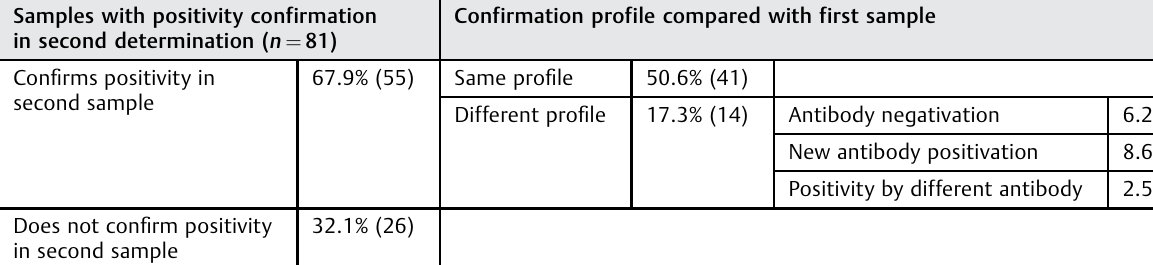
Table 8 Analysis of positivity con fi rmation pro fi le in the second sample Samples with positivity confirmation Confirmation profile compared with first in second determination ( n ¼ 81)